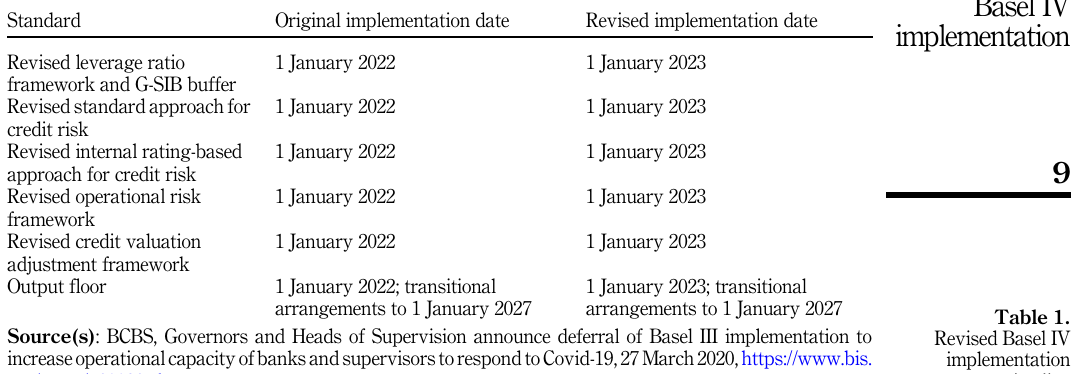
Table 1. Revised Basel